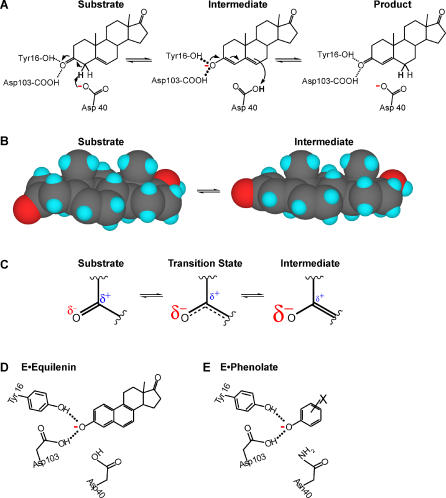
Geometric and Electrostatic Changes in the KSI Reaction(A) Mechanism of KSI catalyzed isomerization of 5-androstene-3,17-dione (substrate) to 4-androstene-3,17-dione (product). In the first step a general base, Asp40, removes a proton from the steroid to form a dienolate intermediate (via a dienolate-like transition state), which receives hydrogen bonds from an oxyanion hole consisting of Tyr16 and protonated Asp103. In the second step of the reaction the steroid is reprotonated at a different position to give the product.(B) Geometric changes accompanying the first half of the KSI reaction. Oxygen is shown in red, carbon in grey, hydrogen in blue. The ring geometry changes in the transition state and in the intermediate, becoming more planar in the intermediate. The sp
2-hybridized carbonyl oxygen in the substrate becomes a predominantly sp
3-hybridized oxyanion. Structures were generated using CaCHE 4.93 (Fujitsu, Tokyo, Japan) MOPAC PM5 geometry optimization [
150] and rendered using CS Chem3D Pro 5.0 (CambridgeSoft, Cambridge, Massachusetts, United States).
(C) Electrostatic changes at the carbonyl group accompanying the first half of the KSI reaction. The larger “δ−” refers to increased negative charge on the oxygen atom as the reaction proceeds. The dienolate-like transition state is expected to be between the substrate and dienolate intermediate in charge arrangement, but closer to the high-energy intermediate.(D) Schematic depiction of the steroid equilenin bound at the KSI active site. Equilenin geometrically and electrostatically resembles the dienolate reaction intermediate and transition state.(E) Schematic depiction of a single-ringed phenolate bound at the active site of KSI
D40N, the mutant enzyme used for this work. The Asp40Asn mutation mimics the protonated aspartate found in the intermediate and equilenin complexes, see (A) and (D), and leads to tighter binding of phenolate and other intermediate analogs [
69,
71].